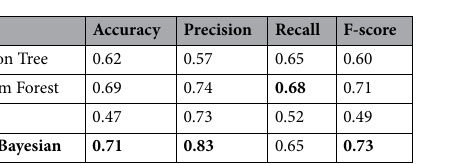
Figure 4. Classification results of the Naive Bayesian model based on different feature combinations.